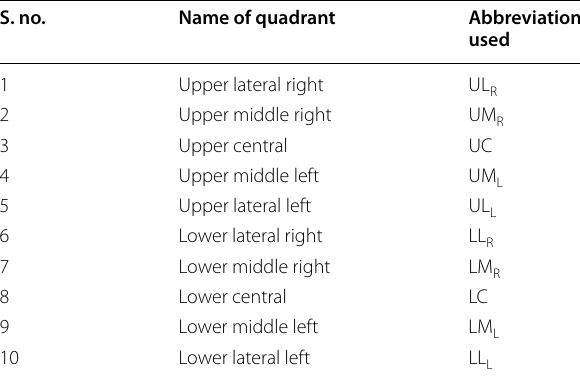
Table 1 The nomenclature and abbreviations assigned to the quadrants into which lips were